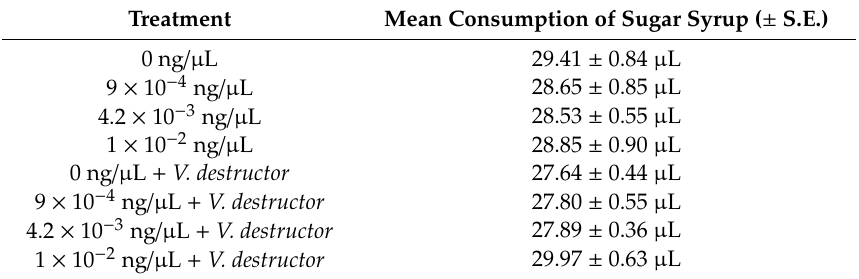
Table1. Meanconsumptionofsugarsyrup( ± S.E.)ofbeesexposedtosublethaldosesofclothianidinand / or V. destructor . The bees were treated with clothianidin (0 ng clothianidin / µ L, 9 × 10 − 4 ng clothianidin / µ L, 4.2 × 10 − 3 ng clothianidin / µ L, and 1 × 10 − 2 ng clothianidin / µ L) and / or V. destructor (Vd) for 14 days. No significant differences were observed based on Kruskal–Wallis test ( α of